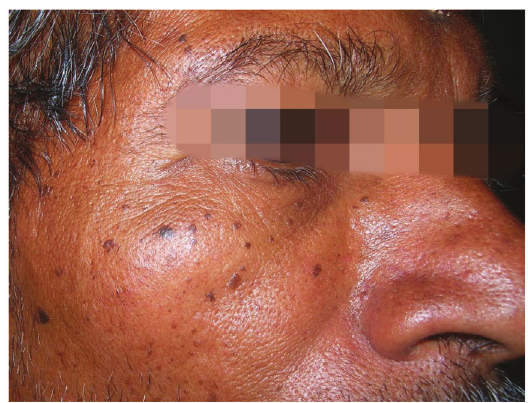
Figure 6. Dermatosis papulosis nigra. This figure is an original image created by the Dr. K.T. Ashique for this publication and written informed consent was obtained from the